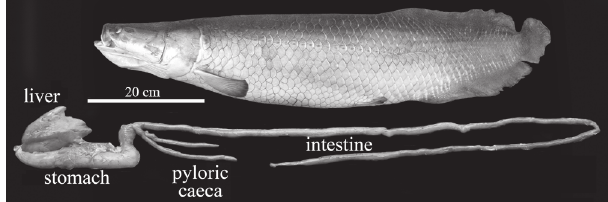
Fig. 6. Anatomy of the digestive tract from a 78 cm TL juvenile Arapaima from Mamirauá Reserve, Brazil (now a dried skeleton in Manaus, INPA 26582, collected by C. Arantes, Nov. 2006). The intestine in this specimen was 1.77 times TL, which was longer than the average for both Essequibo and Mamirauá